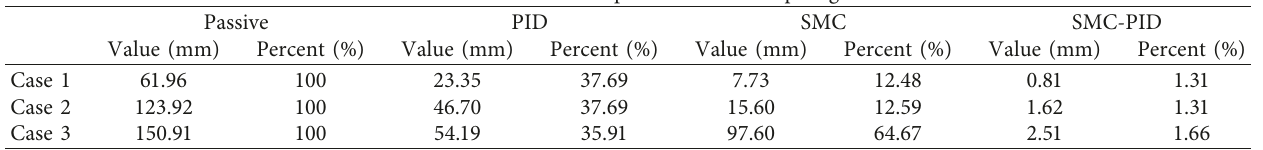
Table 2: The maximum displacement of the sprung mass.